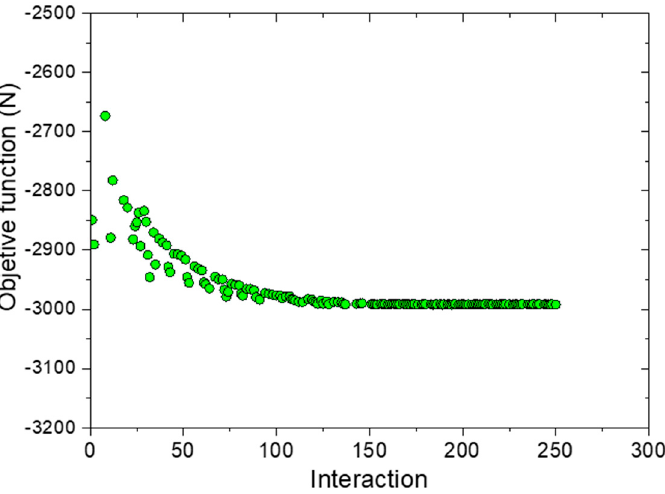
Figure 4. Convergence curve of the optimization process for the AOPT panel.